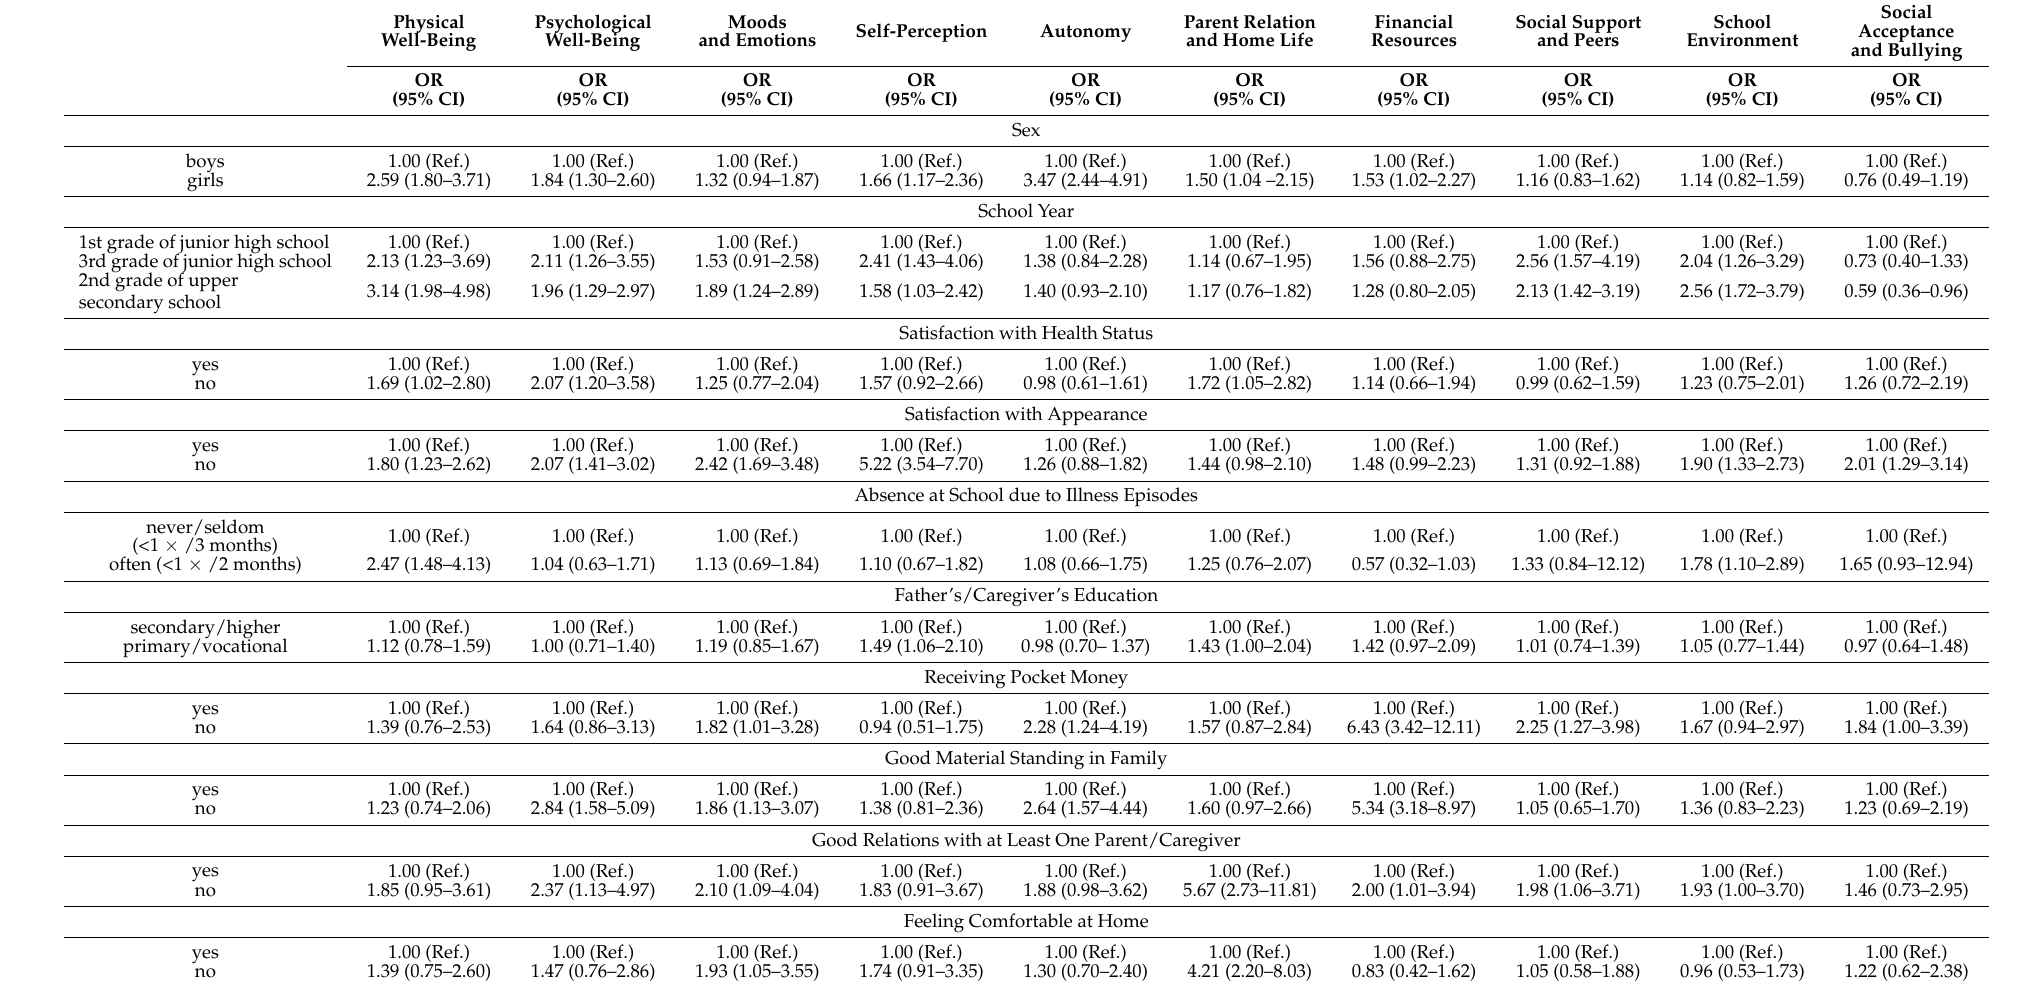
Moods and Emotions Self-Perception Autonomy